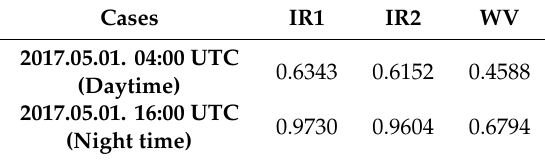
Table 2. The correlation coe ffi cients between the COMS MWIR and the WV, IR1, IR2 channels. Cases